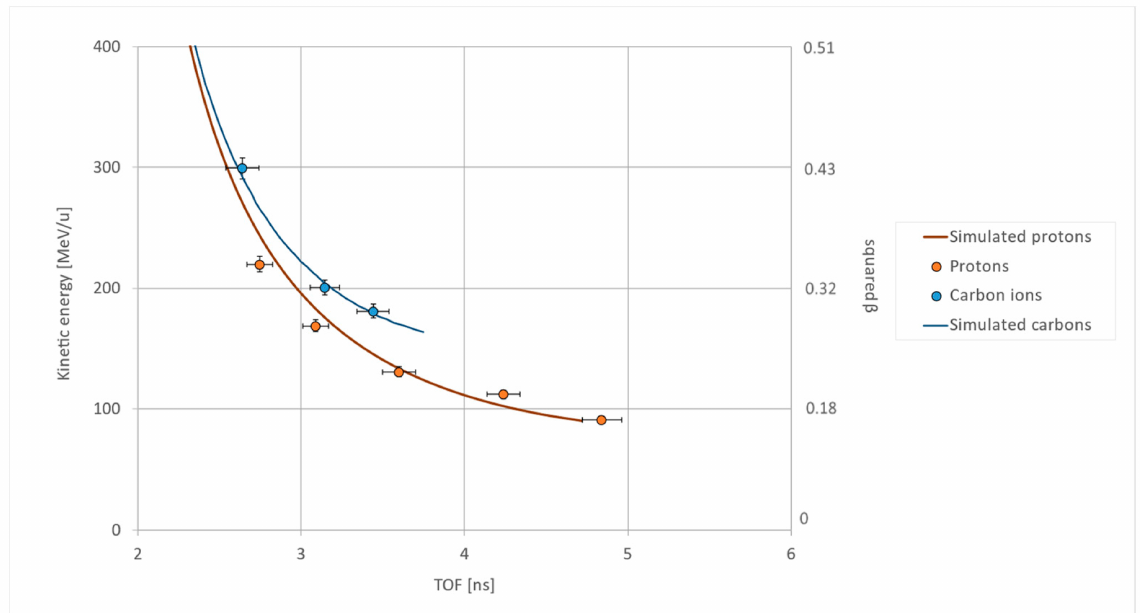
Figure 4. ToF measurements (in ns) made at TIPFA (proton beam line, orange dots) and CNAO (carbon beam line, blue dots). The solid lines result from the simulation of protons (orange line) and carbon ions (blue line) traversing the detector; they are derived from a solution of the Bethe-Bloch equation (see text). The consistency between measured values and simulation results confirms LIDAL ToF measurements and its consequent capability in evaluating β . For the measurement session with carbon ions at 400 MeV/n, only SDU data were